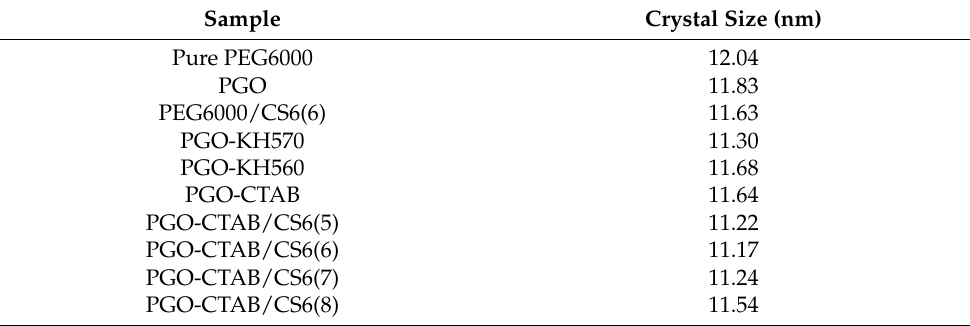
Table 4. Average crystal size of pure PEG6000 and various composite PCMs. Sample Crystal Size